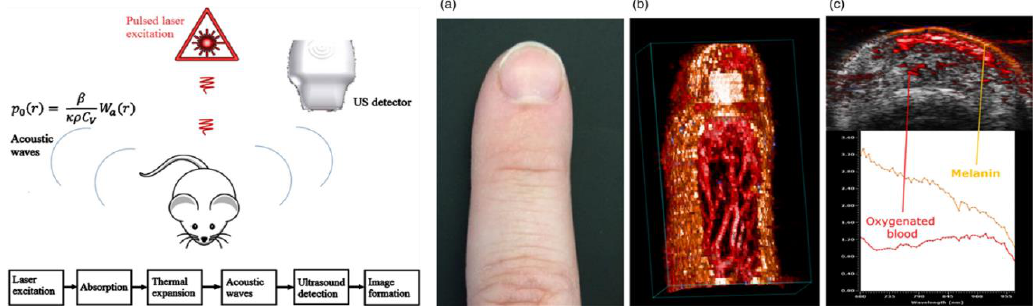
Figure 11. Overview of the physics and processing involved in photoacoustic imaging (PAI) ( left ), and a sample of 2D and 3D vasculatures acquired via PAI from hemoglobin and melanin emissions without contrast agents ( right , a – c ). Reproduced with permission from Ref. [132].